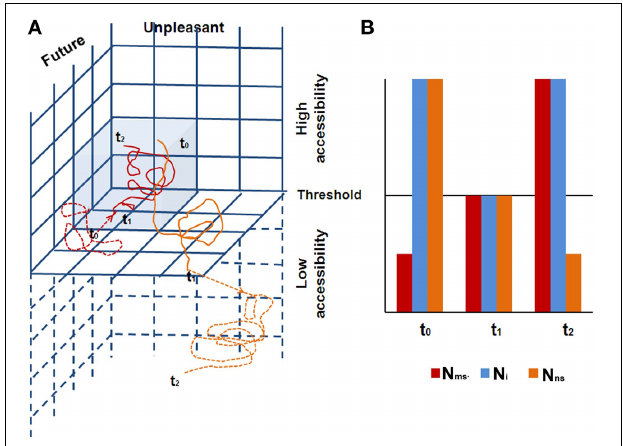
FIGURE 4 | (A) The two trajectories in the CSS are shown (red denotes the CC/MS trajectory, and orange the EC/NS trajectory), with their dynamic behavior. A full line denotes access awareness, while a dashed line denotes phenomenal awareness. The figure shows a quarter of the CSS, depicting the future/unpleasant space. Gray denotes the CC/Ms 3D space. The three time points demonstrate the typical antagonistic behavior of the two trajectories. At t 0 , the CC/MS trajectory is under the threshold for access awareness; hence one has access awareness to the EC/NS trajectory. For example, one is driving, decoupled from sensory awareness (present moment and relatively neutral emotionally) while mind wandering, imagining a future unpleasant experience. At t 1 there is a threat on the road, resulting in a phase transition: the CC/MS trajectory arrives at the threshold for access awareness, and at the same time, the EC/NS trajectory shifts under the threshold for access awareness. At t 2 , the CC/MS trajectory expresses negative arousal due to the danger, while the EC/NS trajectory becomes even more unpleasant due to self-criticism for lack of awareness to the driving, continuing at a subliminal level of awareness; (B) a schematic diagram of the neural space behavior over the same specific three time points. N1 corresponds to the neural space of the CC/MS sphere, and N2 to the neural space of the EC/NS sphere. At t 0 , FPN is collaborating with N2 (one phenomenally experiences thoughts). At the short transition at t 1 , all networks are at threshold level for access awareness (one phenomenally experiences “no thoughts”), and at t 2 the FPN collaborates with N1 (one phenomenally experiences high concentration while